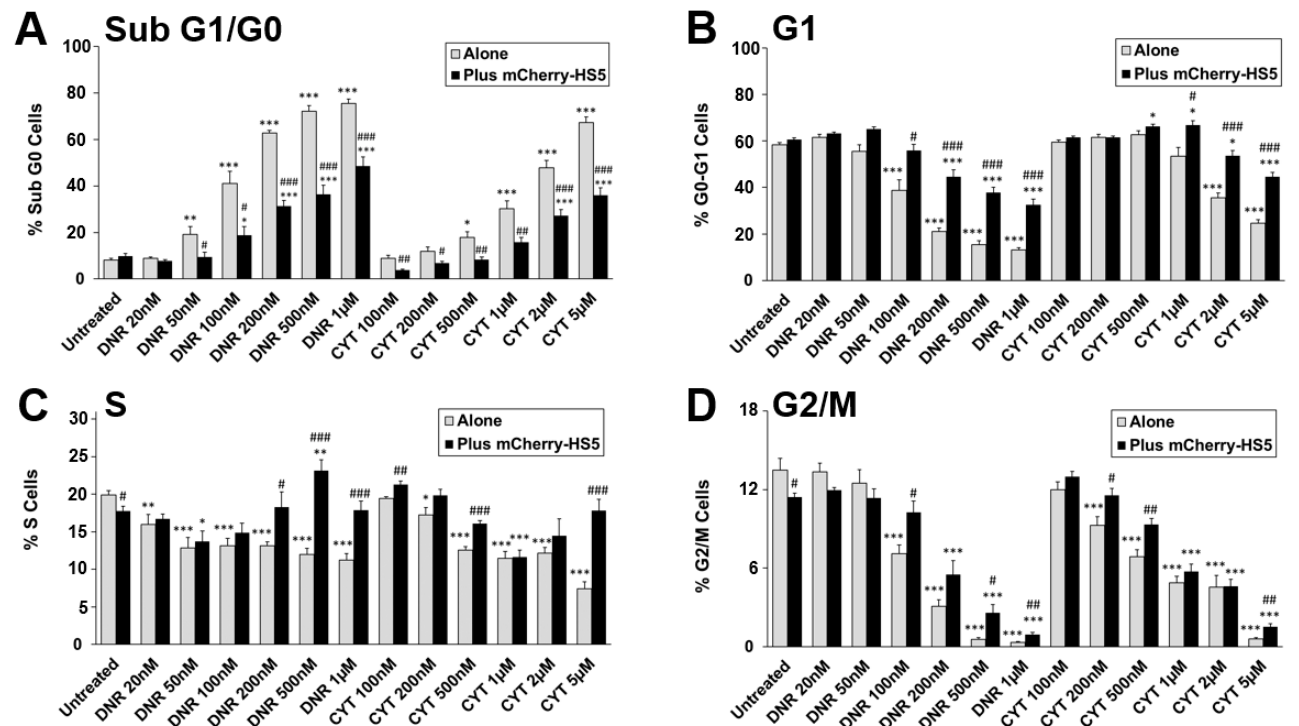
Figure 4. Analysis of percentage of eGFP-MV4-11 cells in each phase of the cell cycle cultured alone or in co-culture with mCherry-HS5 after drug exposure for 3 days. eGFP-MV4-11 cells cultured alone or in the presence of mCherry-HS5 cells were left untreated or were treated with daunorubicin (DNR) or cytarabine (CYT) for 3 days. Samples were ethanol-fixed and stained with propidium iodide for analysis of the cell cycle by FACS. Histograms represent mean values ± S.E. Percentage of cells in sub-G1/G0 phase ( A ), G1 ( B ), S ( C ) and G2/M ( D ) phases of the cell cycle. * p < 0.05, ** p < 0.01, *** p < 0.005 ANOVA versus control untreated in the same culture condition. # p < 0.05, ## p < 0.01, ### p < 0.005 post-hoc Student T-test cells co-cultured with mCherry-HS5 cells vs. cells cultured alone treated with the same concentration of drug treatment.